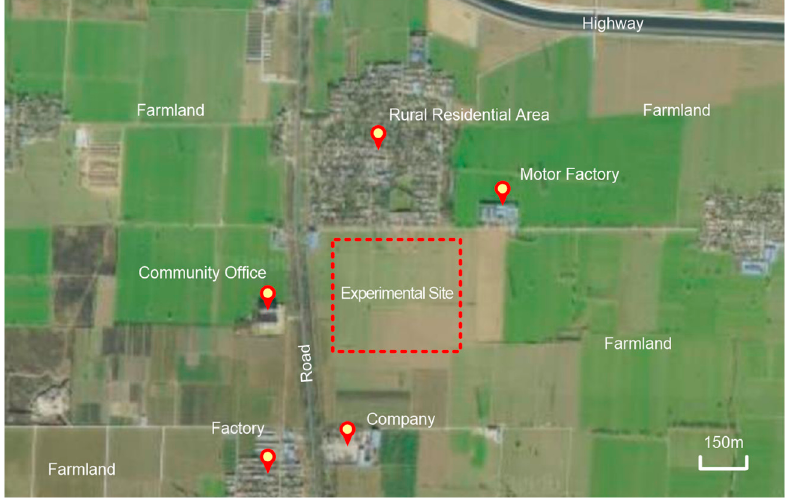
Figure 12. Flight measurements at different altitudes: ( a ) 5 m; ( b ) 10 m; ( c ) 15 m.